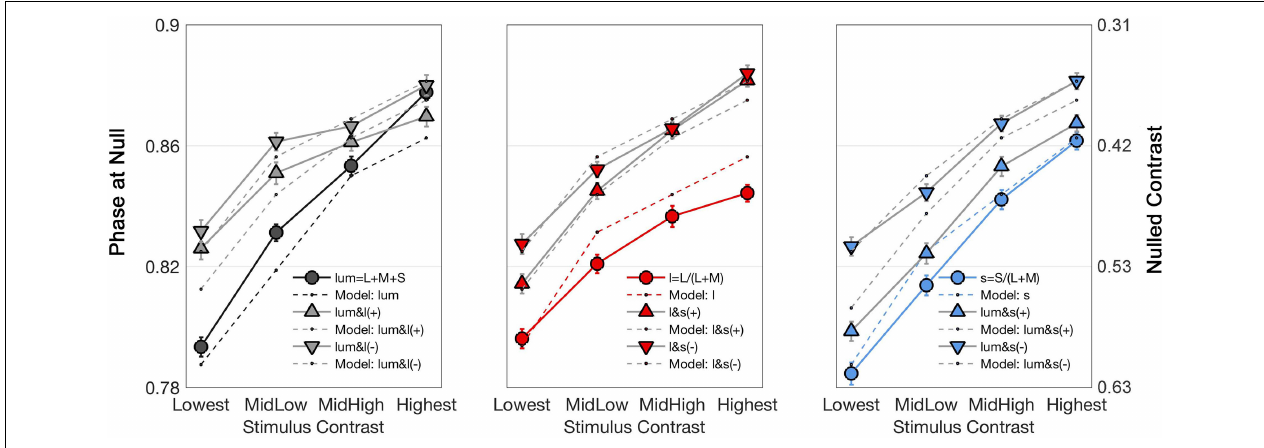
FIGURE 4 | Curves showing the time (in terms of π , left axis) and contrast (percentage of the maximal stimulus contrast, right axis) at which the identity point was reached for the average of all observers as a function of stimulus contrasts. Each graph shows the responses to one cardinal and to two non-cardinal stimulation: lum-axis and stimuli in the lum/l plane (left), l-axis and stimuli in the l/s plane (center), and s-axis and stimuli in the lum/s plane (right). In each graph, circle markers correspond to data from cardinal stimulation while triangle markers correspond to data from the same polarity (labeled as “ + ”) modulation and inverted triangles for the data from the opposite polarity (labeled as “–”) modulation. Solid lines connect data points while dashed lines are model fits. Note that there is a flattening effect at high contrasts, therefore the lowest contrast is taken for